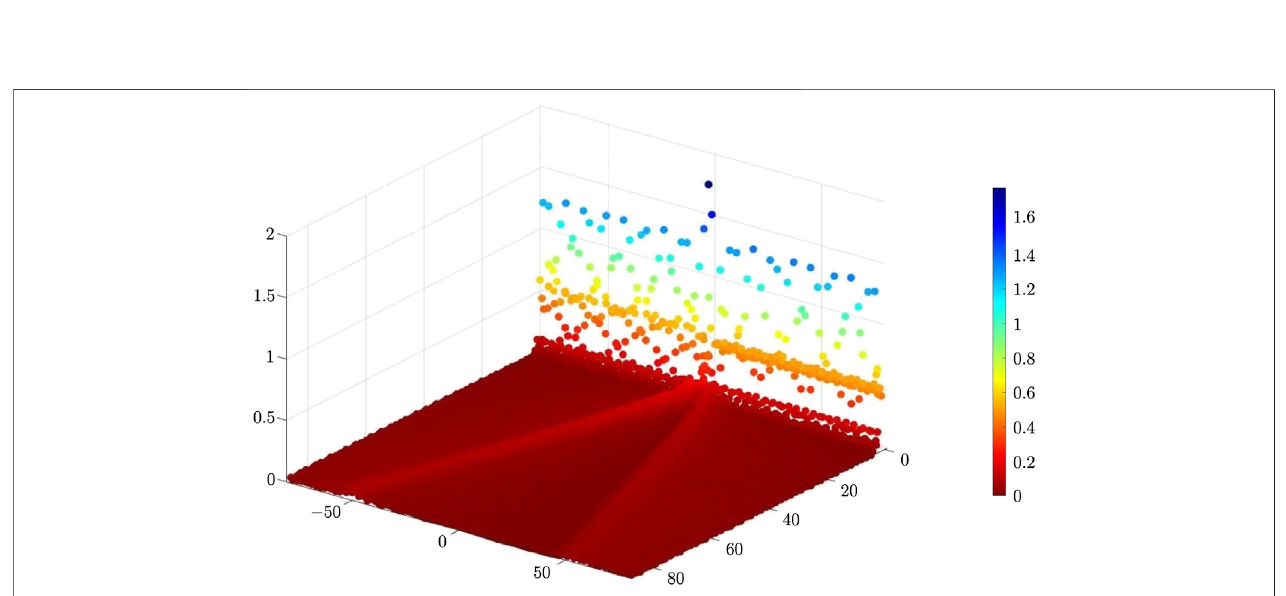
FIGURE 13 | Displacement fi eld of the lattice ’ s masses when Ω * (cid:1) 1, ω 0 (cid:1) 0 . 9 and the point force acts in the vertical direction.